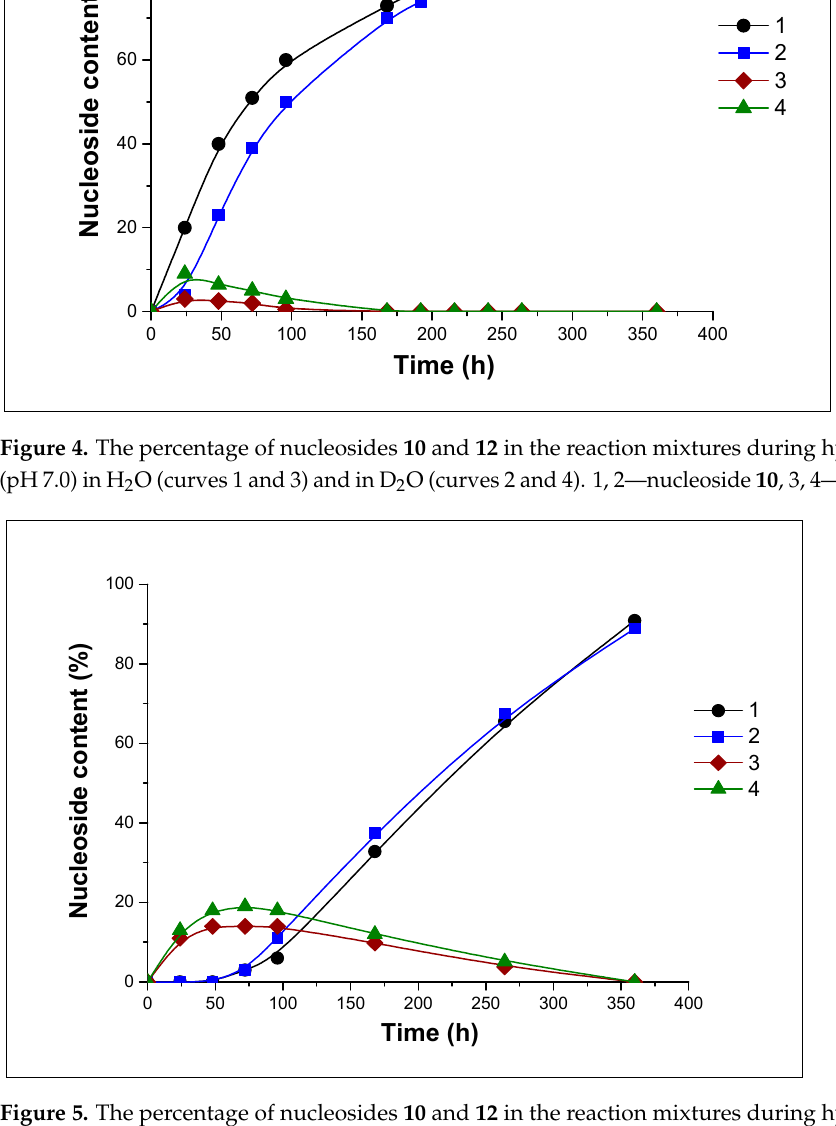
Figure 6. The UV spectra of compounds 10 , 11 , 12 , and 14 (D 2 O, appeared pH 4.1). The set of UV spectra for hydrolysis of 11 is shown in Figure 7. The picture is somewhat complicated due to the overlay of spectra of individual components.